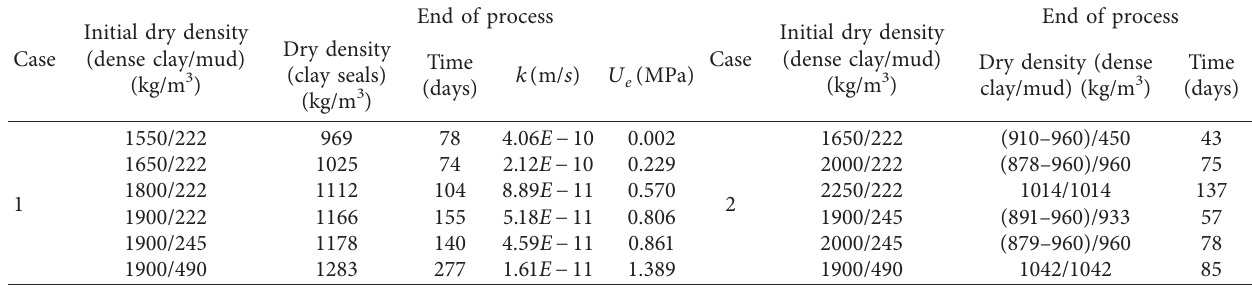
Table 3: Numerical simulation of maturation in reference to real VDH with Holmehus